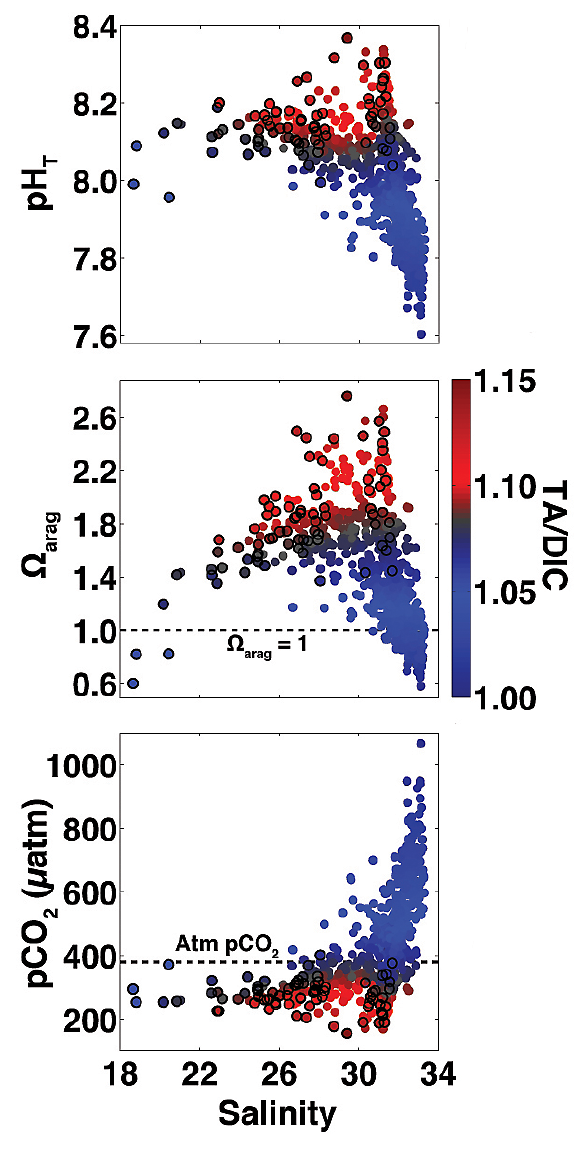
Fig. 3. pH T (top), (cid:127) arag (middle), and p CO 2 (bottom;µatm) as a function of salinity and TA/DIC ratio. The dashed horizontal line in the middle panel is the (cid:127) arag = 1 level below which dissolution of aragonite will occur, and the dashed horizontal line in the lower panel is the September 2012 atmospheric p CO 2 in PWS estimated following Evans and Mathis (2013; 380µatm). Surface data ( < 9m) are highlighted in each panel using bold